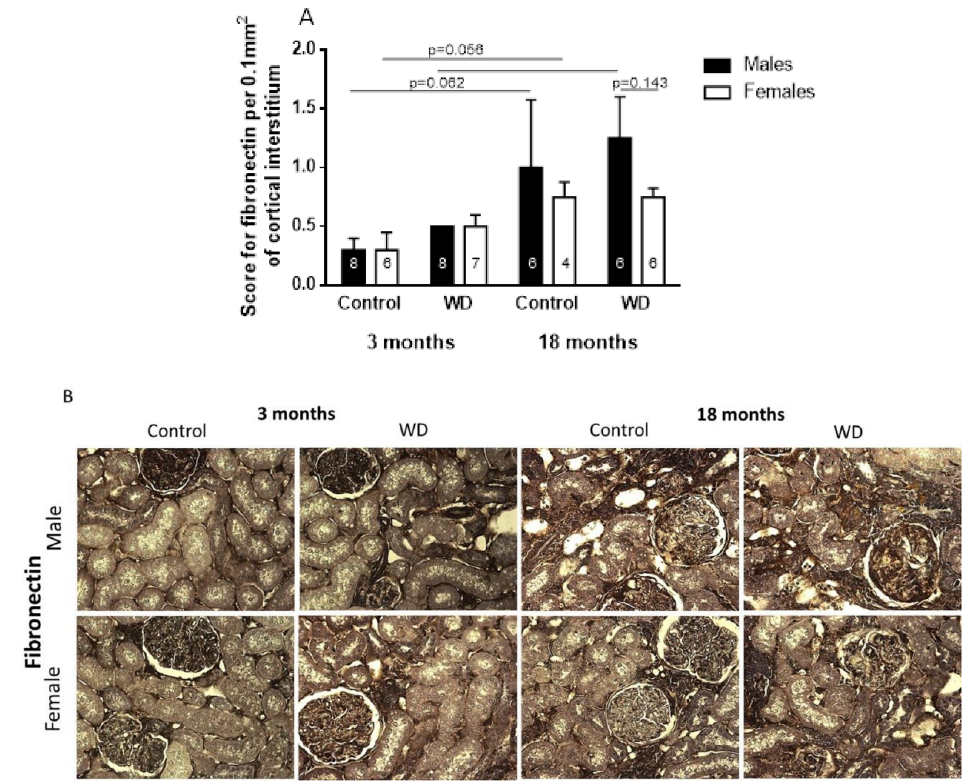
Figure 3. Score ( A ) and representative images ( B ) for fibronectin per 0.1 mm 2 of cortical interstitium in control and water-deprived (WD) 3- and 18-month-old male and female rats (magnification 400 × ). Data are expressed as median and interquartile range (25–75th) ‘_____’: p < 0.05 among the indicated groups. Factorial ANOVA followed by Duncan post-test. Number (n) of animals is indicated inside the column.